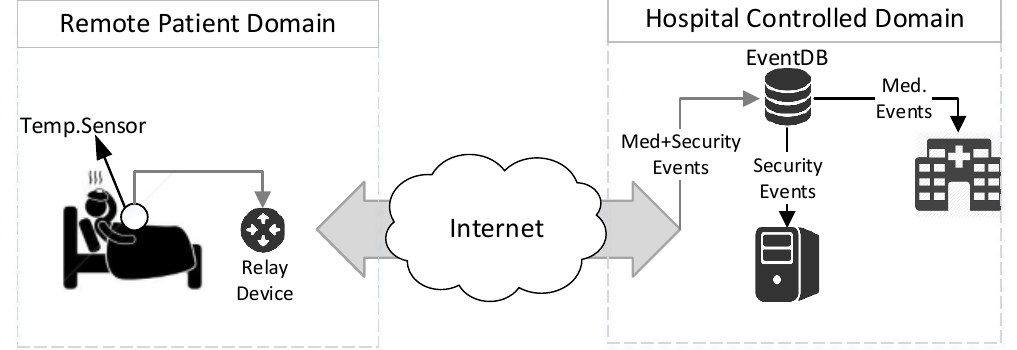
Figure 3. Prototype